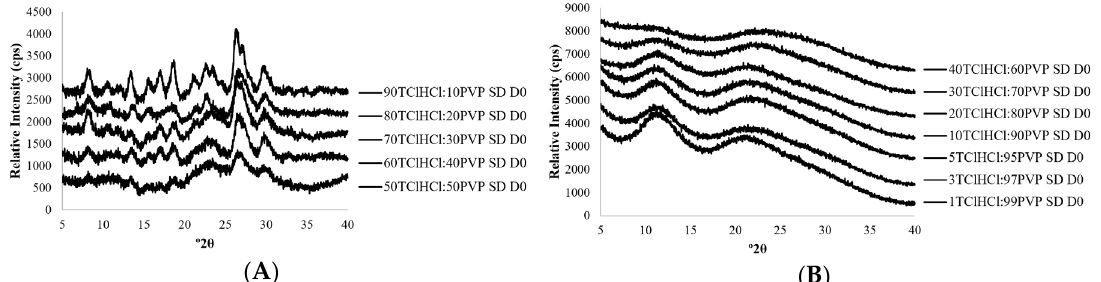
Figure 1. X-ray powder diffraction patterns of TClHCl:PVP solid dispersions (SDs) prepared from ( A ) 50TClHCl:50PVP to 90TClHCl:10PVP, in which all samples exhibited partial crystallinity, and ( B ) 1TClHCl:99PVP to 40TClHCl:60PVP immediately following lyophilization, in which all samples were amorphous.